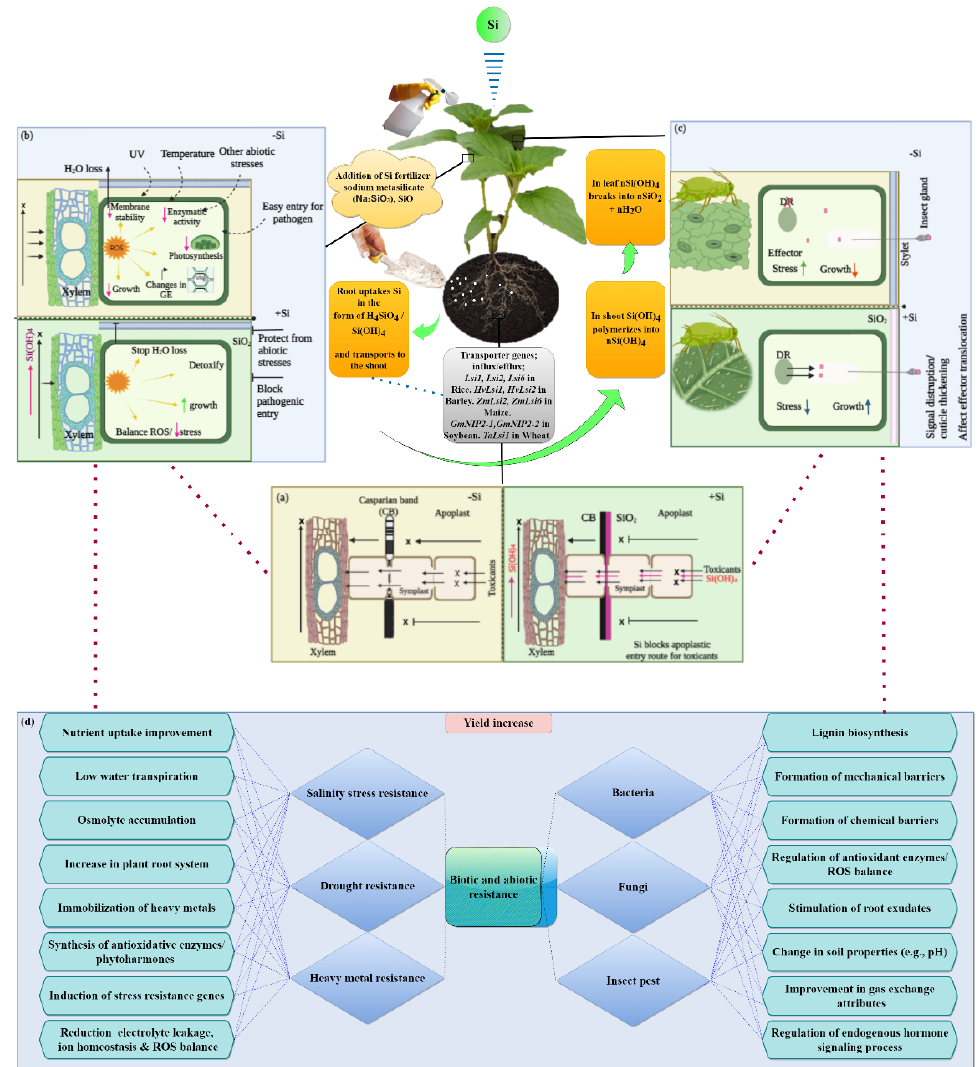
Figure 1. Mechanism of Si-induced apoplastic obstruction and its beneficial effect on the applied plants. ( a ) Conditions before (−Si) and after (+Si) Si application; Si blocks the apoplastic entry route of toxicants, which is the common pathway in addition to the symplastic route to reach the xylem. Casparian bands (CBs) are present, stopping the entry of toxicants, although breaks may occur al- lowing for bypassing routes, particularly under low or −Si conditions. High or +Si improves CB development [76], as well as apoplastic Si deposition (as silica, SiO 2 [77], effectively blocks bypass routes resulting to root-to-shoot translocation of toxicants). ( b ) In +Si plants, when Si translocates to the plant shoot cells, it deposits in the form of SiO 2 , forming a thick layer in the apoplastic region or a mechanical barrier blocking the pathogenic entry, and protects from other abiotic stresses. Fur-